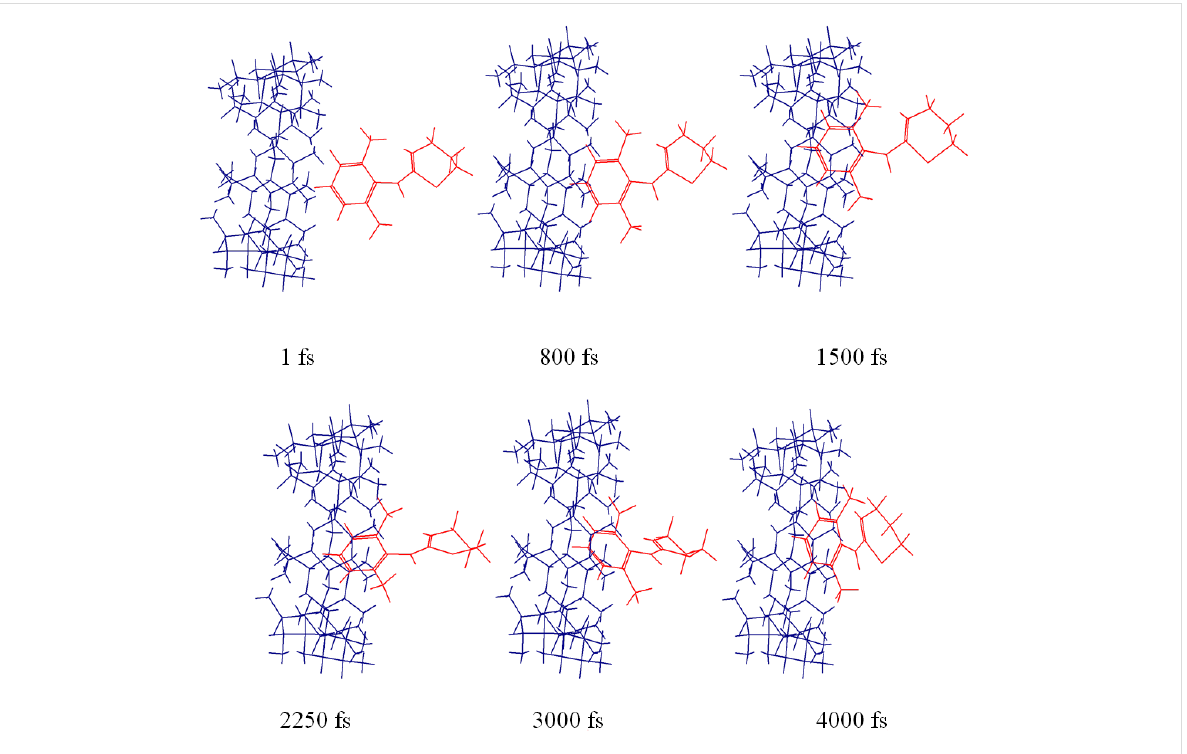
Figure 8: Snapshots showing the inclusion of xylazine into the β -CD cavity as obtained in the MD trajectory from wide side.